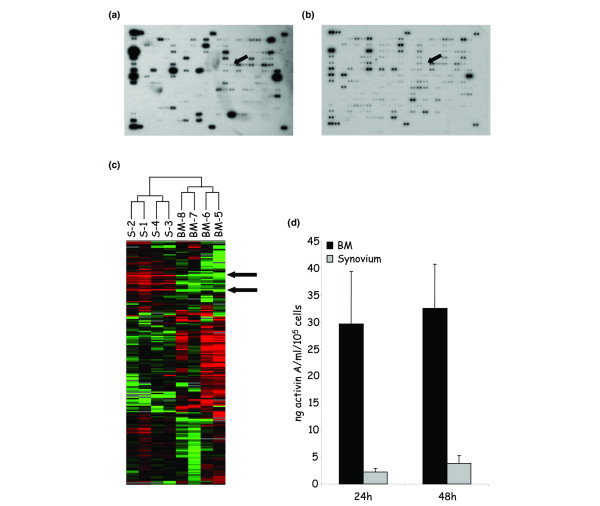
Analysis of genes differentially expressed by normal bone marrow-derived and synovium-derived adherent cells. Total RNAs were extracted from cells at passages 4–6 obtained from healthy donors and reverse-transcribed to radiolabeled cDNAs before hybridization to gene array membranes (Atlas Human Cytokine/Receptor Array; BD Biosciences). Each gene is represented as duplicate spots. (a) One example of a representative array from cells isolated from bone marrow (BM) (n = 4). The arrow represents the activin/inhibin βA subunit. (b) One example of a representative array from synovial cells (n = 4). The arrow represents the activin/inhibin βA subunit. (c) Hierarchical clustering analysis. The dendrogram at the top represents the relationship of the samples according to the similarity in their gene expression profile. Arrows indicate some areas of genes that permit one to discriminate between samples. Red, high expression, green, low expression. (d) Quantification of the secreted activin A by specific ELISA. Results are expressed as the mean of secretion in 24-hour and 48-hour supernatants of four cell samples ± standard error of the mean.